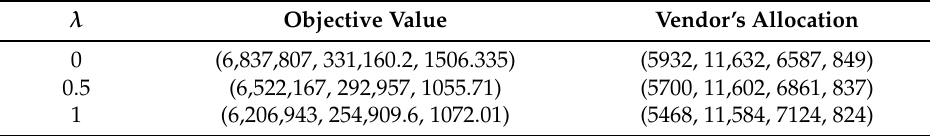
Table 10. Compromise objective value and allocation for case 3 with fixed demand.